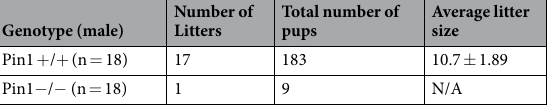
Table 1. The generative ability of transgenic male mice was evaluated by 2 successive matings with wild type female mice (3 male Pin1 + / + or Pin1 − / − mice with 3 female Pin1 + / + each, repeated 2